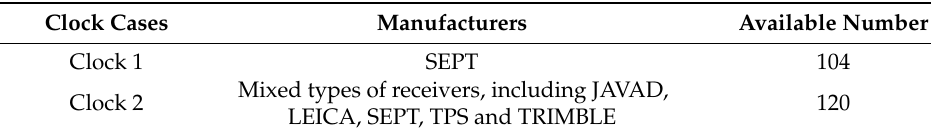
Table 5. Processing strategies of satellite clock estimation.